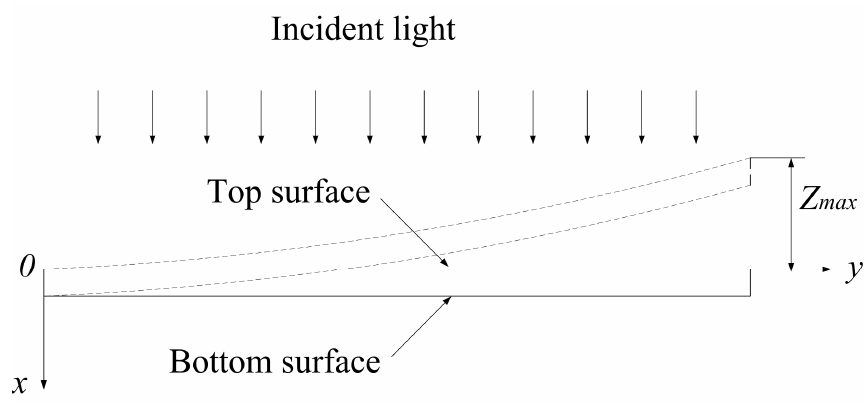
Figure 1. Schematic of a Si microcantilever under incident light and the coordinate